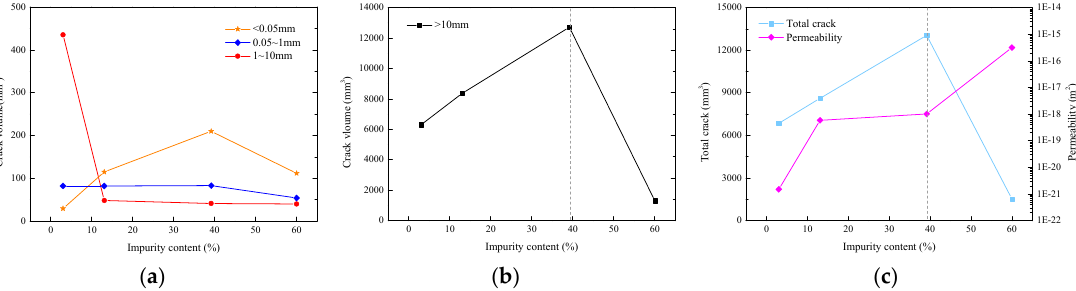
Figure 19. A crack analysis of pure salt after failure with different impurity contents. ( a ) d c < 0.05 mm, 0.05 ≤ d c < 1 mm, and 1 ≤ d c < 10 mm; ( b ) d c ≥ 10 mm; ( c ) Permeability and total pore volume versus confining pressure.